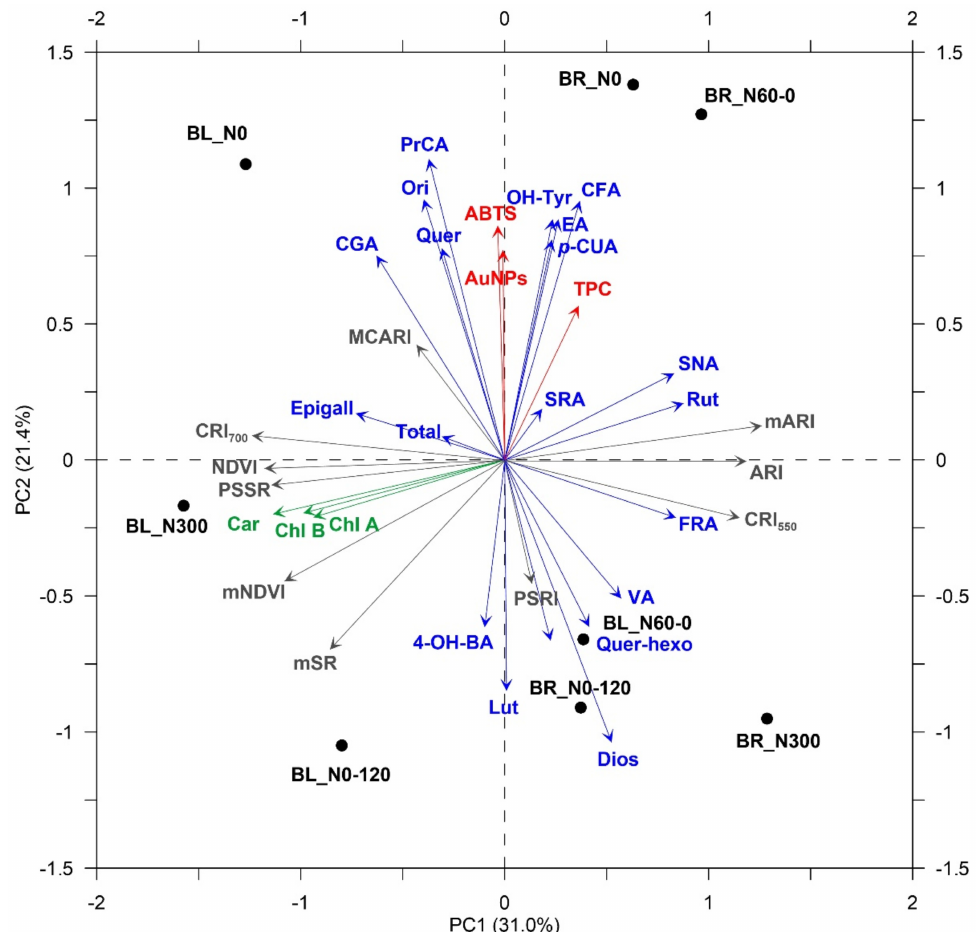
Figure 3. Two-dimensional correlation bi-plot from principal component analysis (PCA) performed on data observed in sprouts obtained from two Triticum aestivum cultivars (Bologna, BL; Bora, BR) subjected to four different N fertilization schedules (N0: unfertilized control; N300: constantly well N fertilized throughout the growth cycle; N60-0: N fertilized only one month after sowing; N0-120: N fertilized only late at initial shoot elongation). Symbols show the standardised scores on PC1 (x-axis) and PC2 (y-axis) for the eight treatments (BL_N0; BL_N300; BL_N60-0; BL_N0-120; BR_N0; BR_N300; BR_N60-0; BR_N0-120); vectors’ coordinates represent the correlations between standardised variables (green group: pigments; red group: results from photometric analysis; blue group: phenolic profile from LC-MS/MS; grey group: reflectance-derivate vegetation indices—see text for labels) and